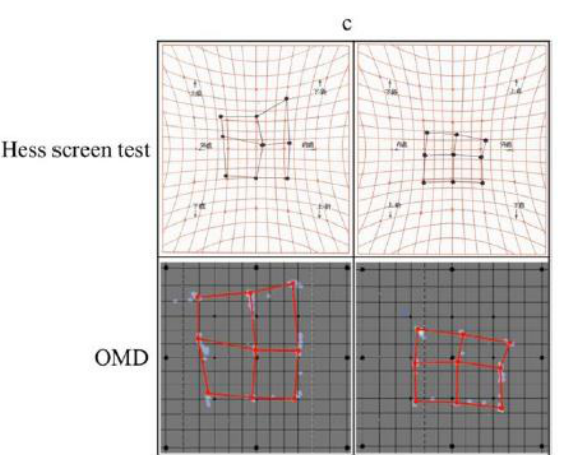
Figure 5 a: Measurements obtained using the Hess screen test and OMD for right eye abducens nerve paralysis; b: Measurements obtained using the Hess screen test and OMD for right eye troch- lear nerve paralysis; c: Measurements obtained using the Hess screen test and OMD for right eye sursumvergence disorder, as- sociated with thyroid-associated ophthalmopathy